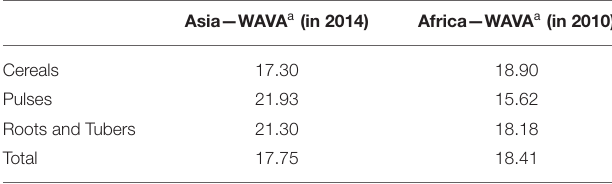
TABLE 2 | Varietal age for crop group in Asia and